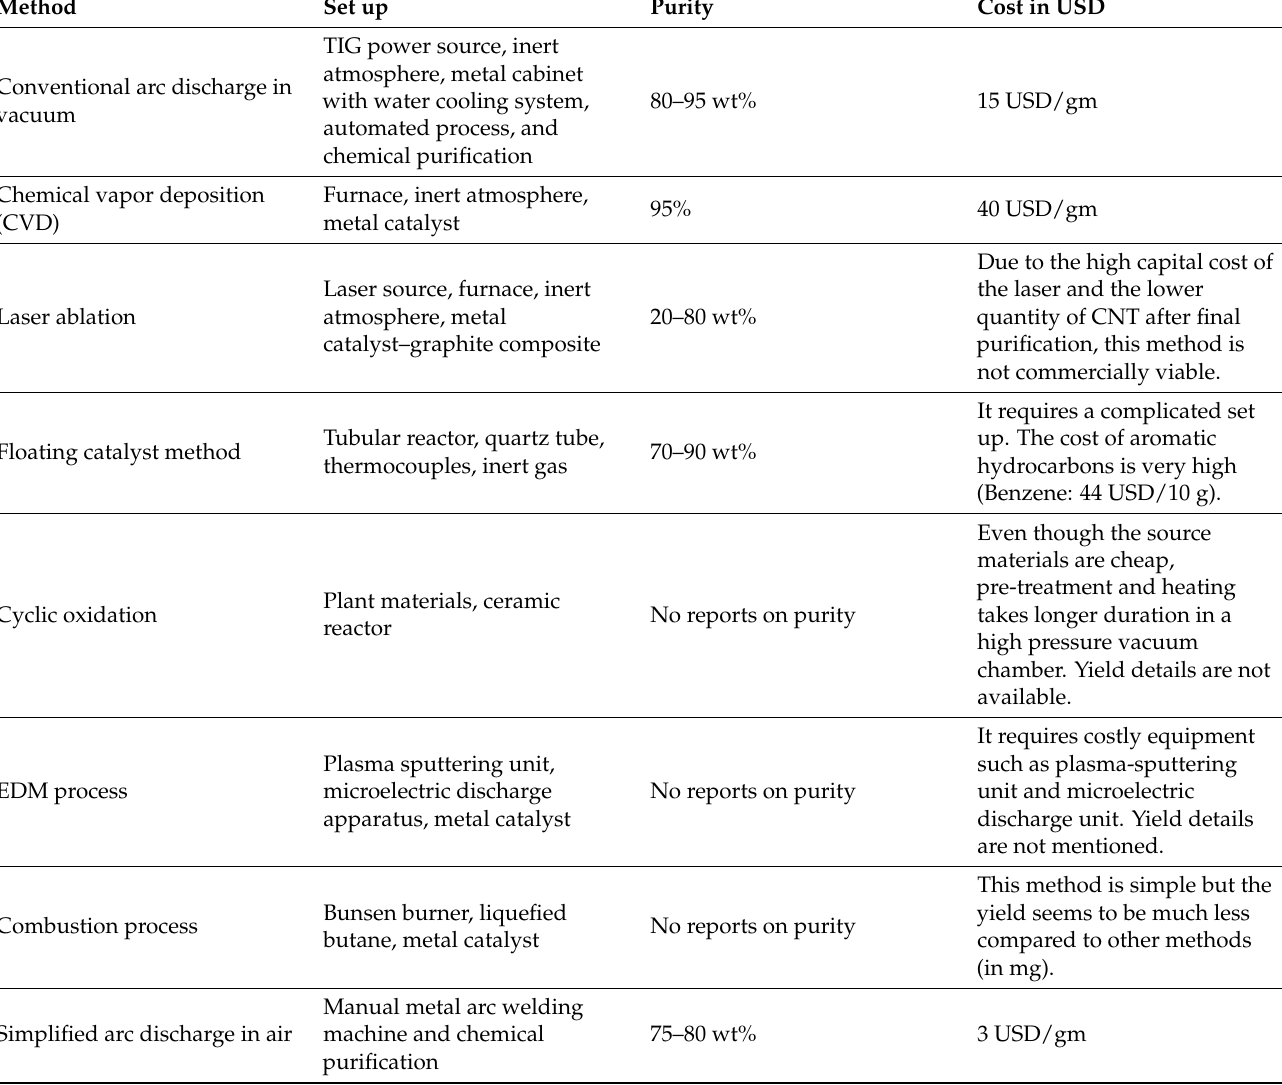
Table 2. Purification stages and each stage’s effective mass